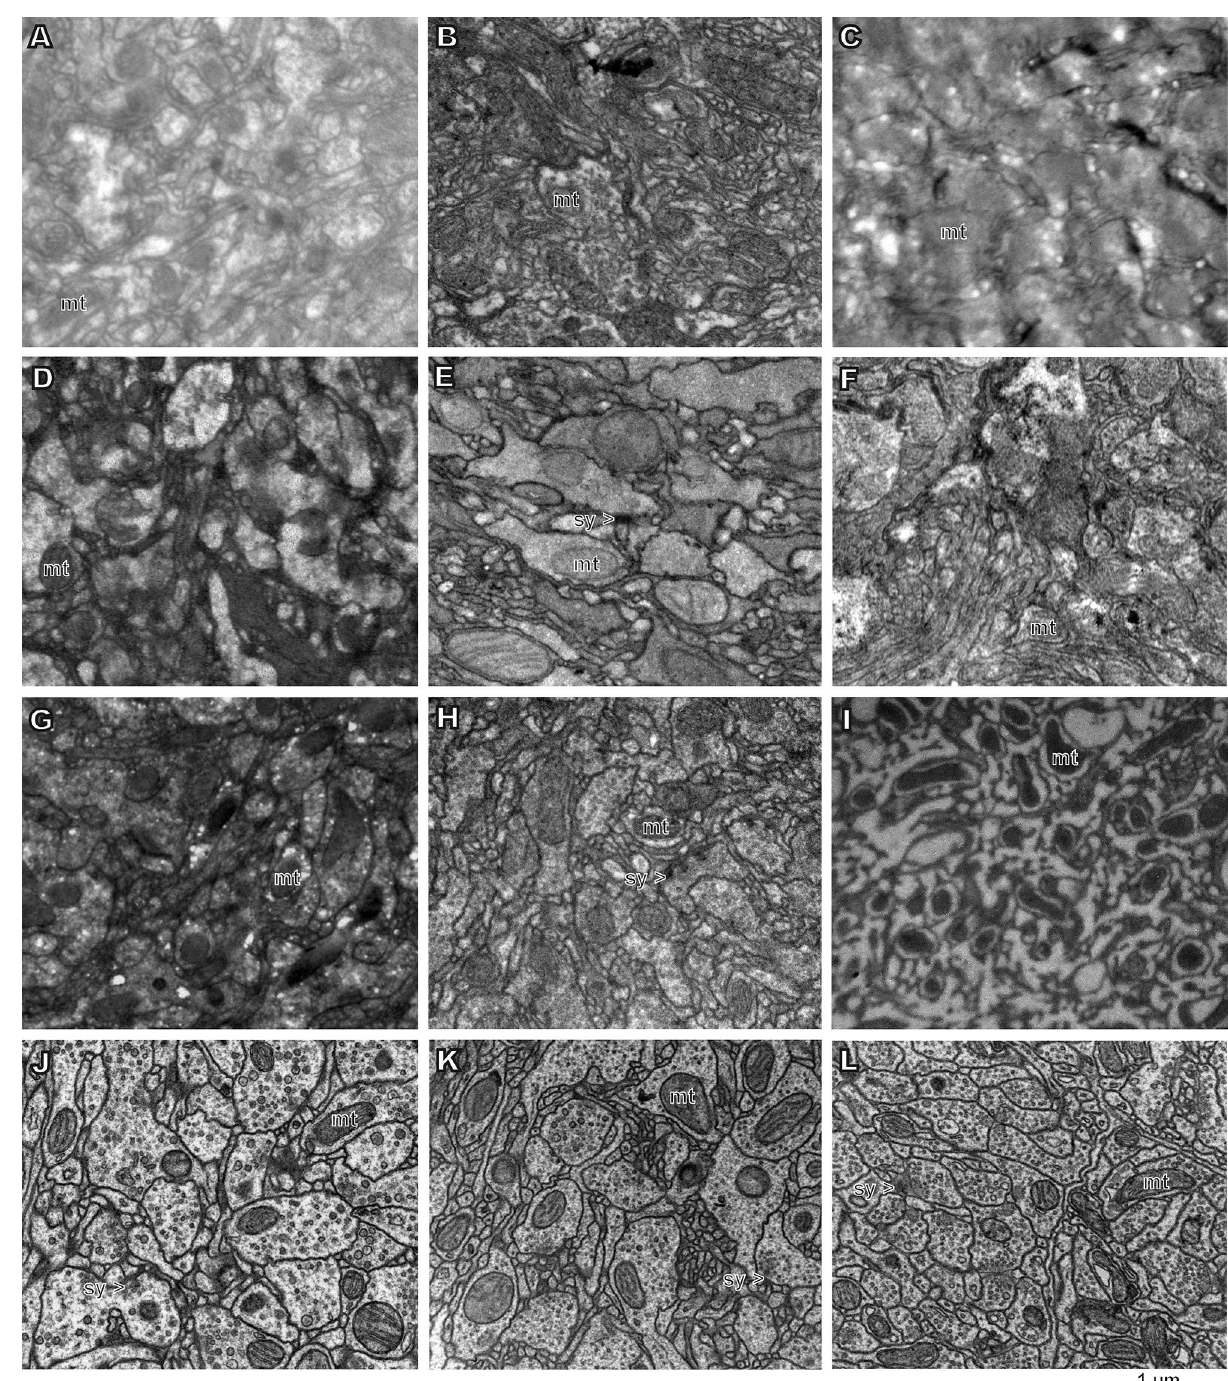
Figure 1. Comparison of the results of various protocols for preparation of whole heads of parasitoid wasp Megaphragma amalphitanum (TEM, areas of neuropil from middle regions of the brain). ( A ) Classical fixation with GA and staining with OsO 410 ; ( B ) OTO 34 ; ( C ) GA + PFA, RO and TA 13 ; ( D ) GA + PFA, OTO, UA, PbAsp 14